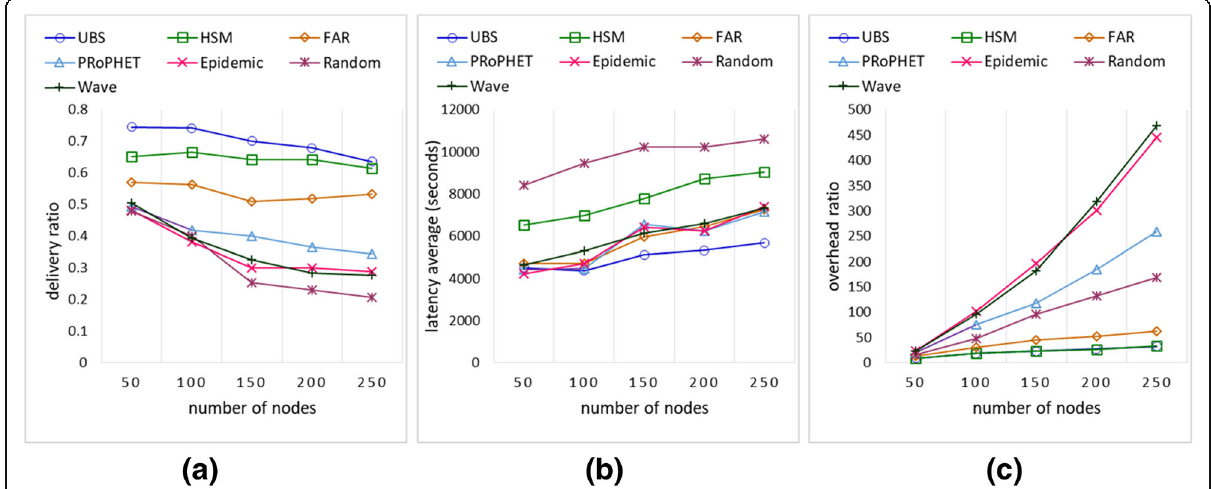
Fig. 8 The performance of schemes by varying number of